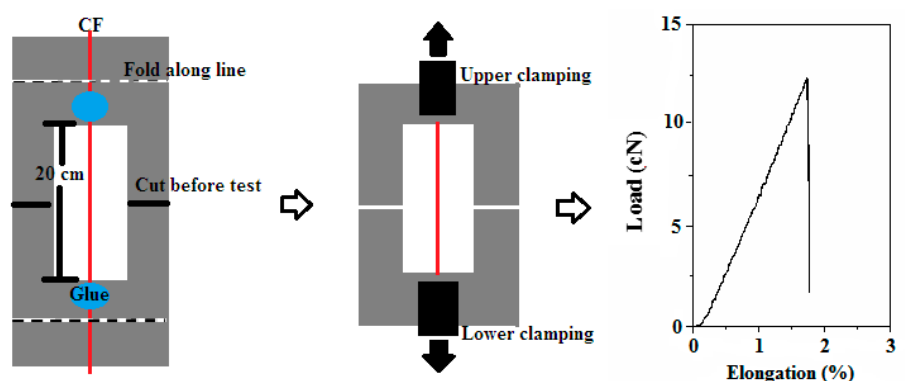
Figure 3. Schematic illustration of the monofilament fibre tensile testing process: sample preparation, testing procedure and load–elongation curve.